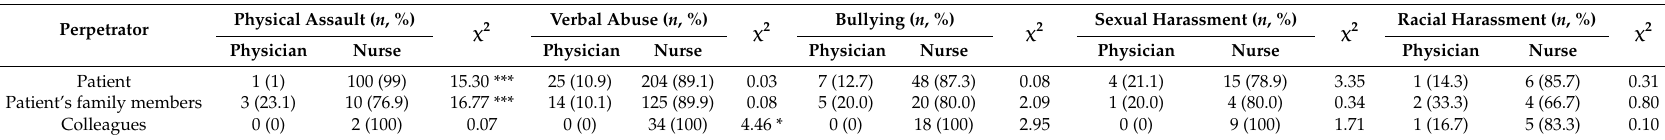
Table 3. Frequency (%) and Pearson χ 2 of perpetrators towards physicians and nurses in relation to physical assault, verbal abuse, bullying, sexual harassment, and racial harassment ( n = 720).